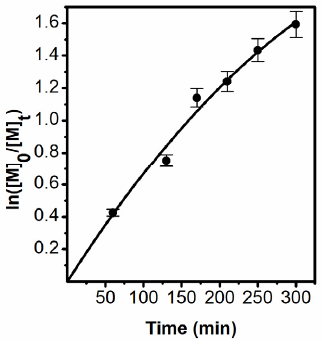
Table 2. Conditions of syntheses and characteristics of PBs and MI.